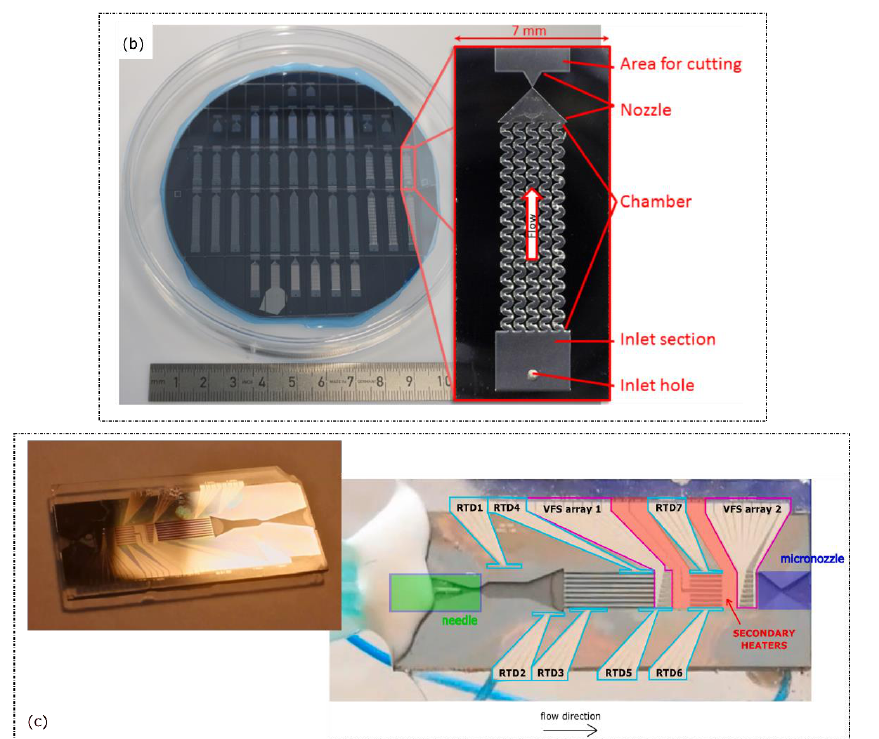
Figure 4. Manufactured VLMs in parallel microchannels configuration: ( a ) Cen and Xu [17]; ( b ) Silva et al. [18]; ( c ) Fontanarosa et al. [25].